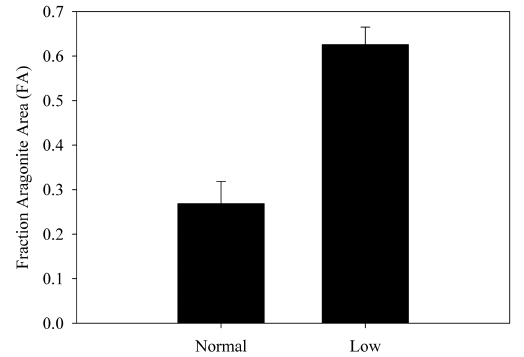
Figure 7. Fraction of aragonite area (FA). Normal=pH n -shells, low=pH low